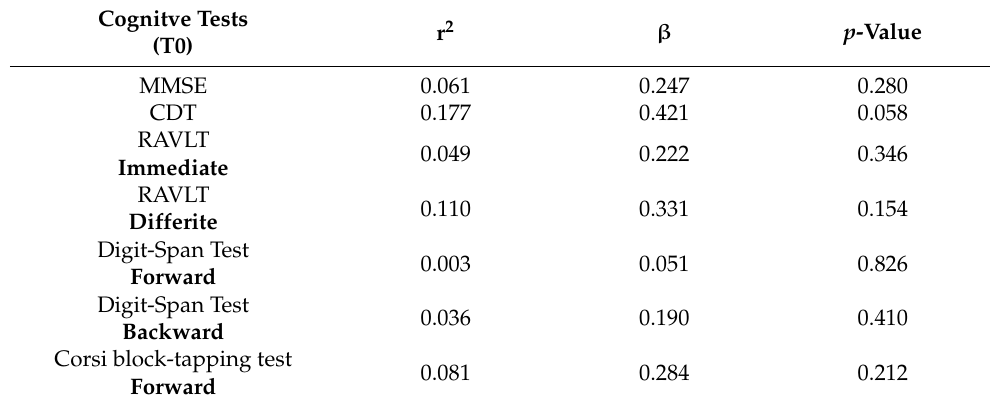
Table 4. Correlations between cognitive results at T0 and verbal recognition at 60 dB after one year from the cochlear